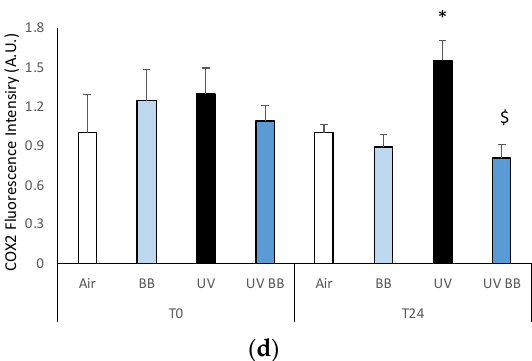
Figure 4. Skin exposure to UV induces inflammatory damage, but pre-treatment with BB extract prevents the induction of pro-inflammatory markers. Ex vivo human skin biopsies were untreated or pre-treated with BB and then exposed to 200 mJ of UVA/UVB, then, AhR and COX2 protein levels were evaluated via immunofluorescence. ( a ) Green fluorescence staining represents AhR protein levels at the original magnification 40×. ( b ) Semi-quantification of AhR green fluorescence intensities produced with ImageJ are depicted in the histogram panel. ( c ) Green fluorescence staining represents COX2 protein levels at the original magnification 40×. ( d ) Semi-quantification of COX2 green fluorescence intensities produced with ImageJ are depicted in the histogram panel. Data are expressed as arbitrary units (average of three independent experiments), * p < 0.05 Air vs. UV; $ p < 0.05 UV vs. UV BB by ANOVA. Scale bar 100 μ m.